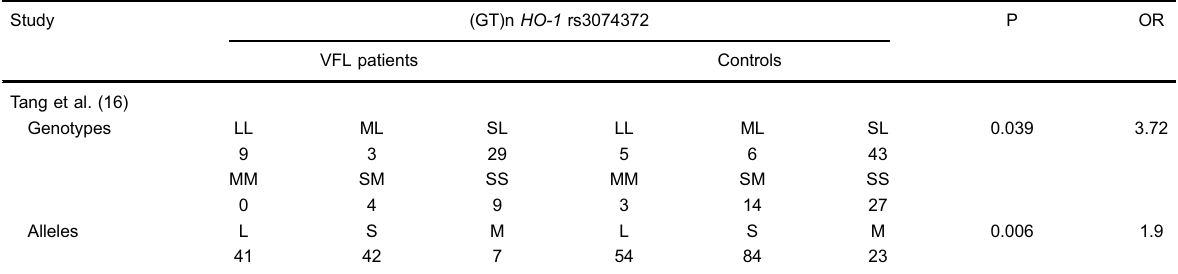
Table 4. Microsatellite repeat polymorphisms in cases of vocal fold leukoplakia (VFL) and controls. Study (GT)n HO-1 rs3074372 P OR VFL patients Controls Tang et al. (16) Genotypes